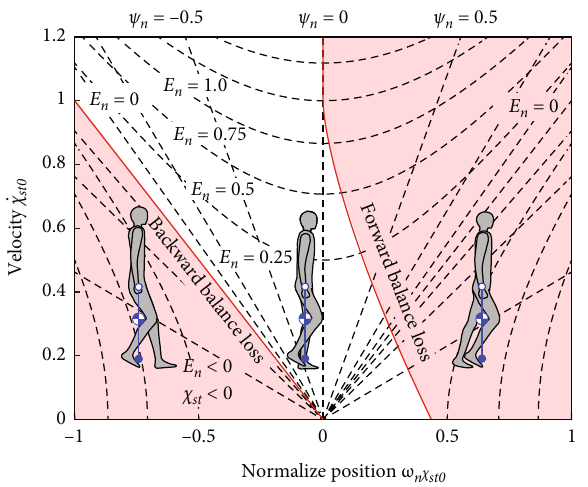
Figure 3: Stable touchdown (un fi lled region) and balance loss regions ( fi lled regions) in the state space of nondimensional stance leg position, which is referred to as the balance map. The fi lled region in E < 0 and χ < 0 is the backward balance loss n st region. Another fi lled region is the forward balance loss